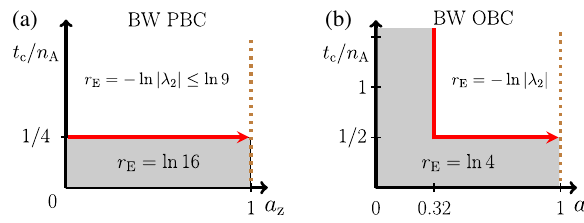
0 . 5 . z ¼ FIG. 9. Phase diagram of the local entanglement rate r BW configuration. (a) For PBC, there is one phase transition; t > t (b) for OBC, there is, again, one discontinuous transition for . The 2 j for c a > a ≈ 0 . 32 . The brown dashed vertical line at a z c indicates a nonentangling SWAP